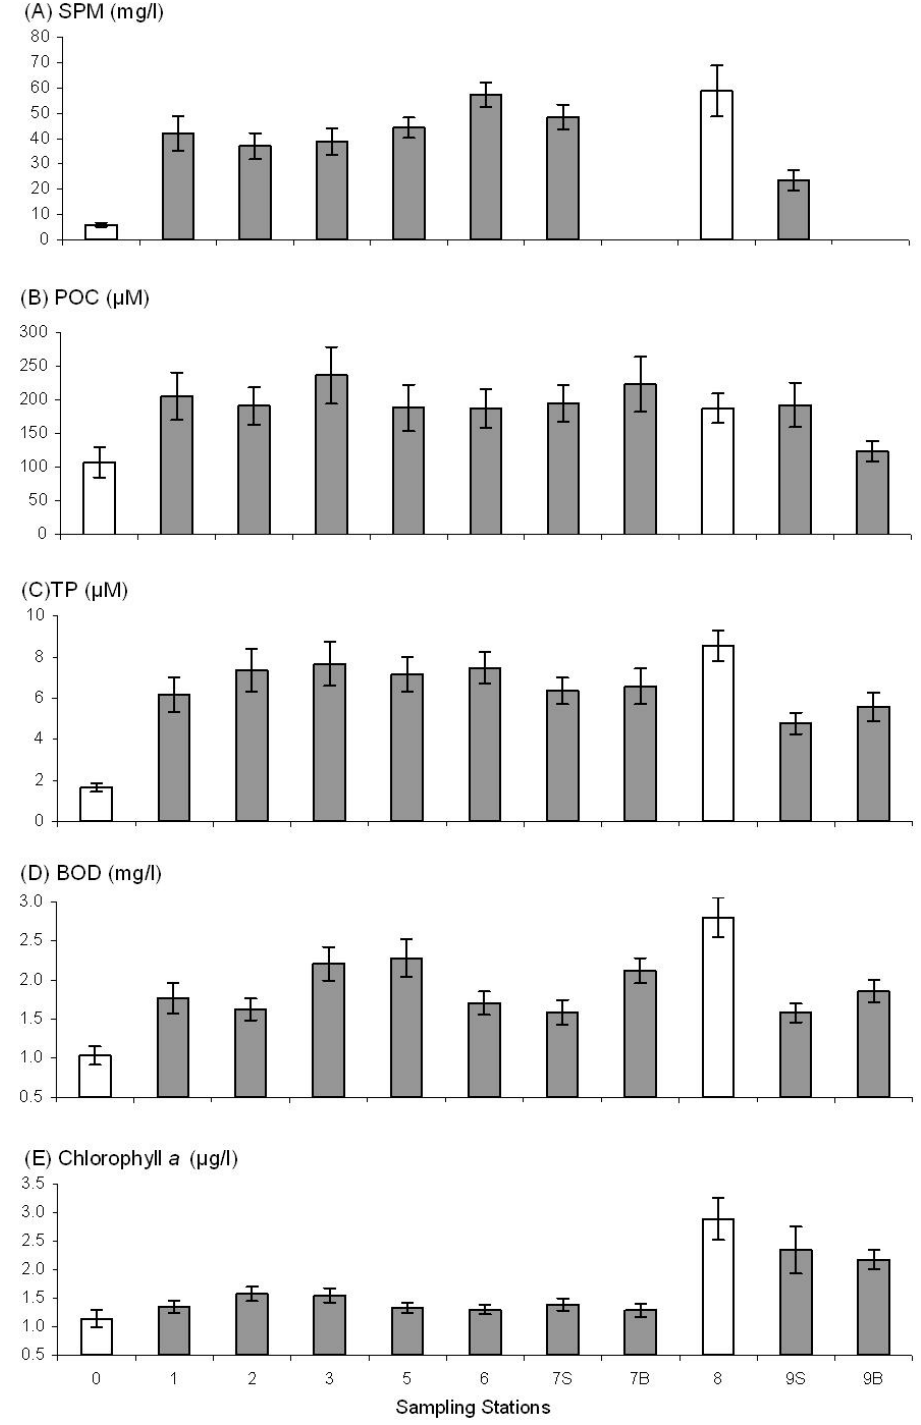
Fig. 5 – Spatial variation of (A) particulate matter in suspension (SPM), (B) particulate organic carbon (POC), (C) total phosphorous (TP), (D) biochemical oxygen demand (BOD) and (E) chlorophyll-a in the fluvial-estuarine system of the Itajaí-Açú River. Overall average and Standard Error for each sampling station, for the entire period sampled (October 2003 to December 2004). The columns in gray represent the stations located in the estuary, and the others in